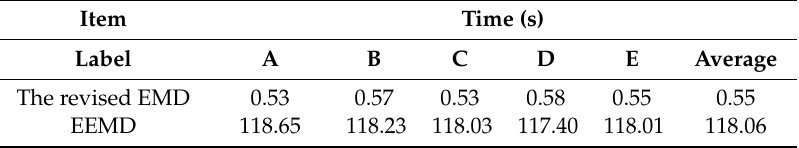
Table 2. The computation time consumption of each method.